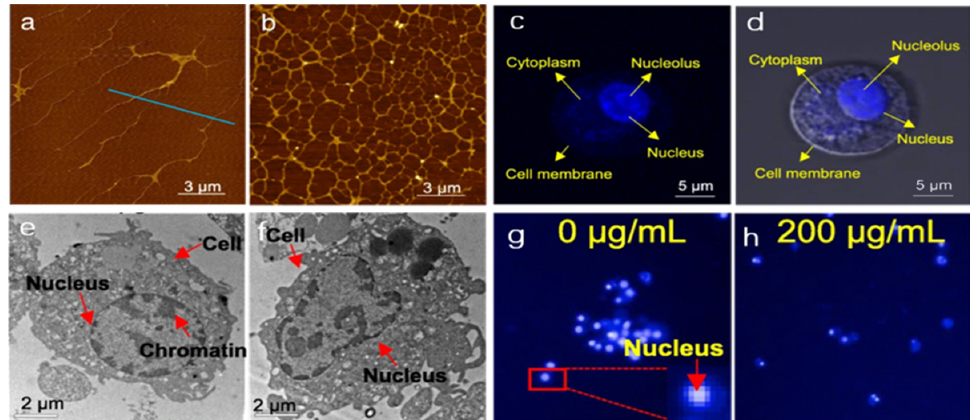
Figure 2. Effects of GQDs on the nucleus and DNA in the nucleus. ( a , b ) DNA chain damage caused by GQDs; ( c , d ) accumulation of GQDs; ( e , f ) nuclear damage by GQDs; ( g , h ) effect of GQDs on nuclear viability and area; ( a , c , e , g ) are the blank control groups, and ( b , d , f , h ) are the exposed groups of 200 mg/L GQDs for 24 h, reproduced from [69], from BioMed Central, 2018.